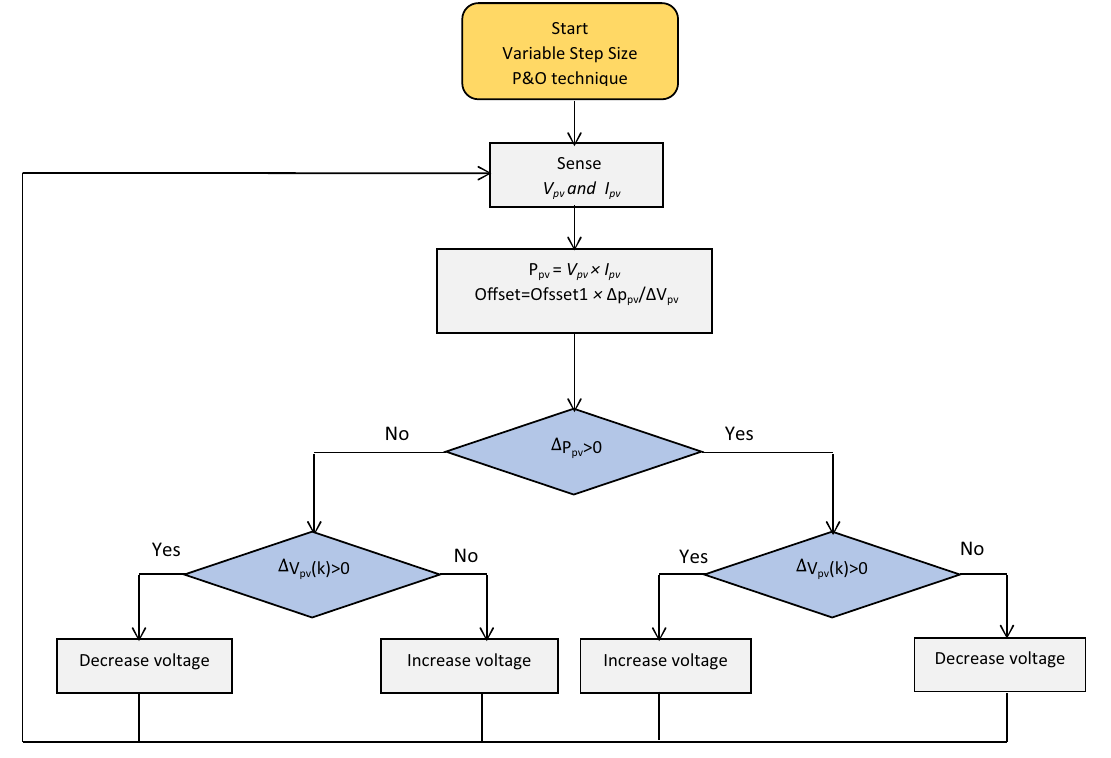
Figure 2. flowchart of Variable step size P&O